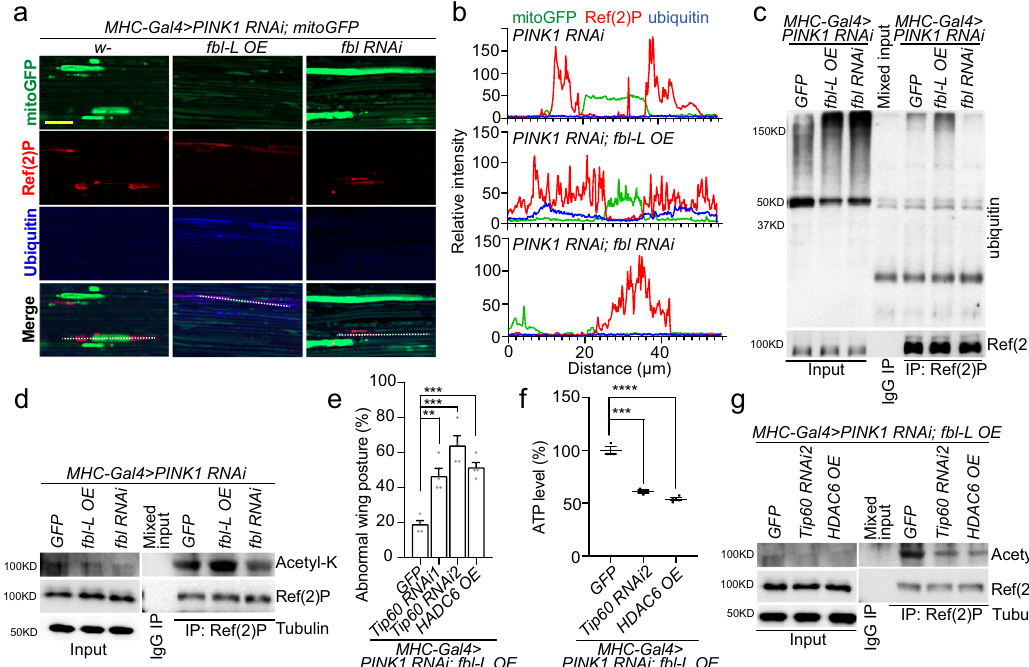
Fig. 6 Fbl Augments Ref(2)P Acetylation to Promote Mitophagy. a Immunostaining of ubiquitin and Ref(2)P puncta signals showing effect of Fbl in PINK1 RNAi fl y muscles. Scale bar, 25 µ m. b Colocalization analysis of a . c Co-immunoprecipitation (co-IP) assay showing interaction of poly-ubiquitin signal and Ref(2)P regulated by fbl in PINK1 RNAi fl ies. d Co-IP assays showing acetyl-lysine signal on Ref(2)P regulated by fbl in PINK1 RNAi fl ies. For assays in ( c , d , and g ) UAS-GFP serves as control, and the rabbit IgG was used in control IP. e Aggravation of Tip60 RNAi and HDAC6 OE on wing posture defect showing their suppression of fbl-L OE in PINK1 RNAi fl ies. 25 fl ies per genotype per group were tested; n = 4 biologically independent groups. f Effects of Tip60 RNAi and HDAC6 OE on ATP level showing their suppression of fbl-L OE in PINK1 RNAi fl ies. n = 3 ( GFP , Tip60 RNAi2 ), n = 4 ( HDAC6 OE ) biologically independent samples in assay ( f ) For all assays in ( e, f ) UAS-GFP serves as control. g Co-IP assays showing acetyl-lysine signal on Ref(2)P suppressed by Tip60 RNAi and HDAC6 OE in the background of PINK1 RNAi plus fbl-L OE. For assays in ( e , f ) the signi fi cance was calculated by using two tailed unpaired t - test. Data are presented as mean values ± SEM; n.s. not statistically signi fi cant; * p < 0.05; ** p < 0.01; *** p < 0.001; **** p < 0.0001. Source data are provided as a Source Data fi